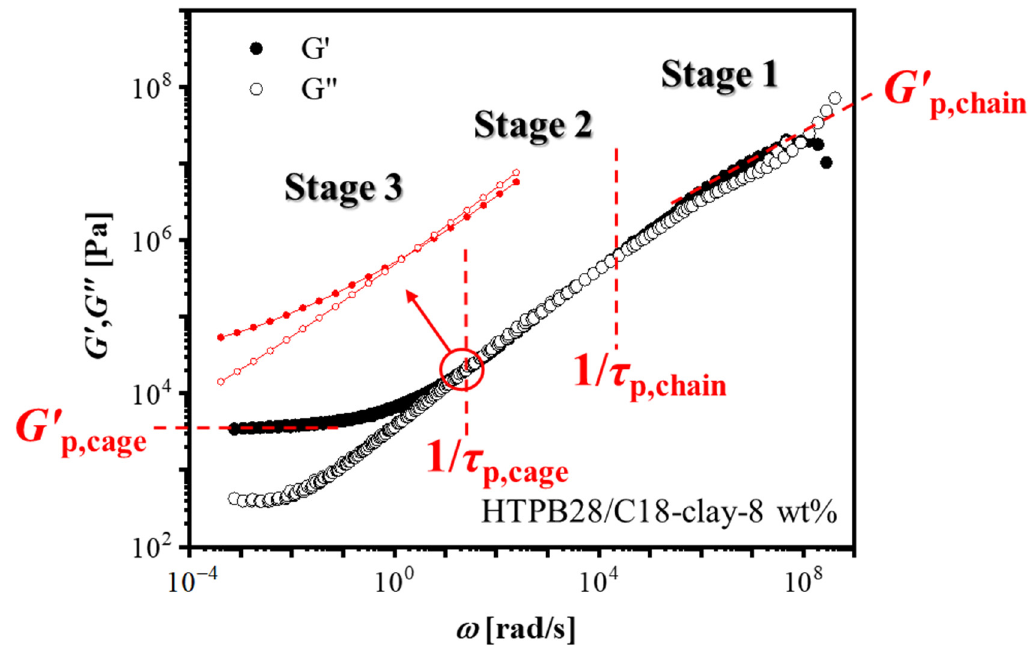
Figure 3. Master curve of HTPB28/C18-clay with 8 wt% clay constructed from the SAOS curves at temperatures between − 60 to 120 °C with 20 °C intervals. The reference temperature ( T ref ) = 20 °C. Solid symbols represent the storage modulus and hollow symbols represent the loss modulus.